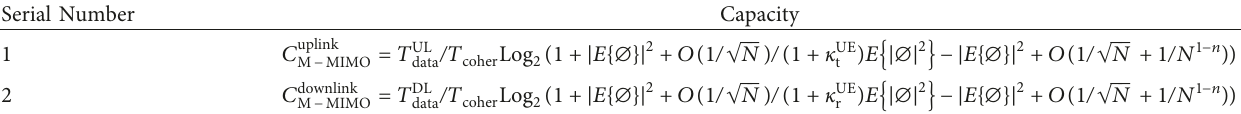
Table 1: Capacity of the M-MIMO system with the single carrier system with hardware impairments